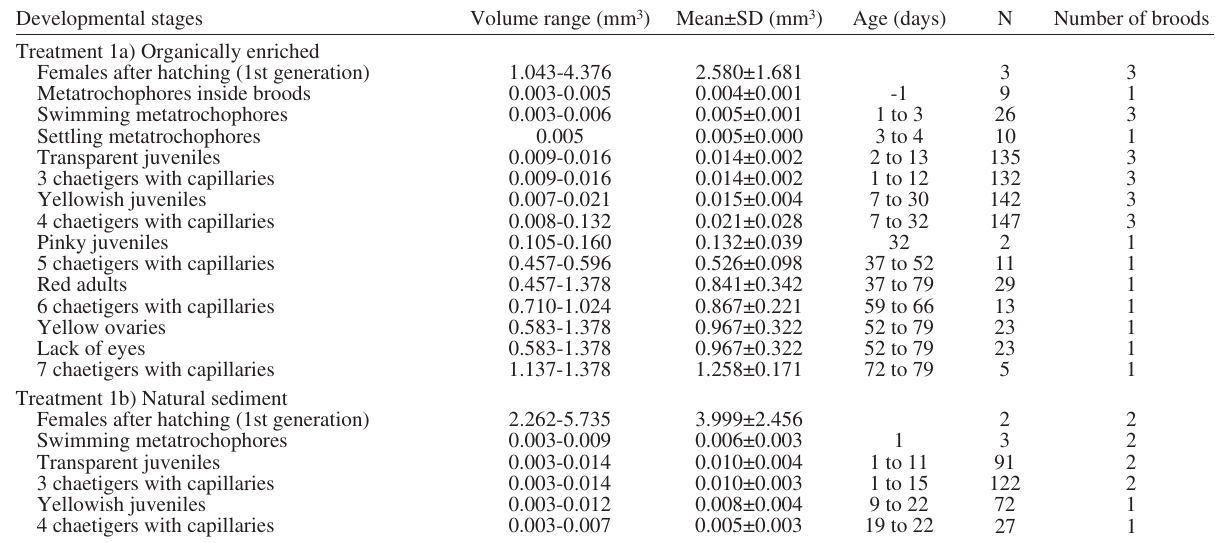
Table 1. – Duration and size of the observed developmental stages of Capitella sp A during experimental series 1. Developmental